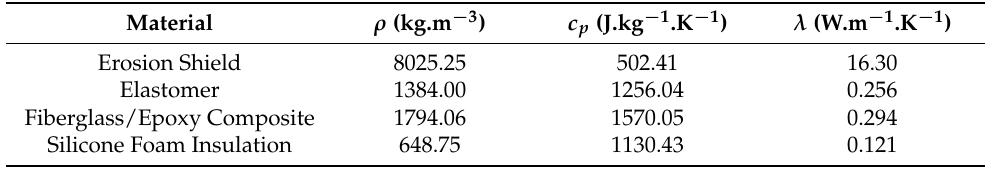
Table 4. Material